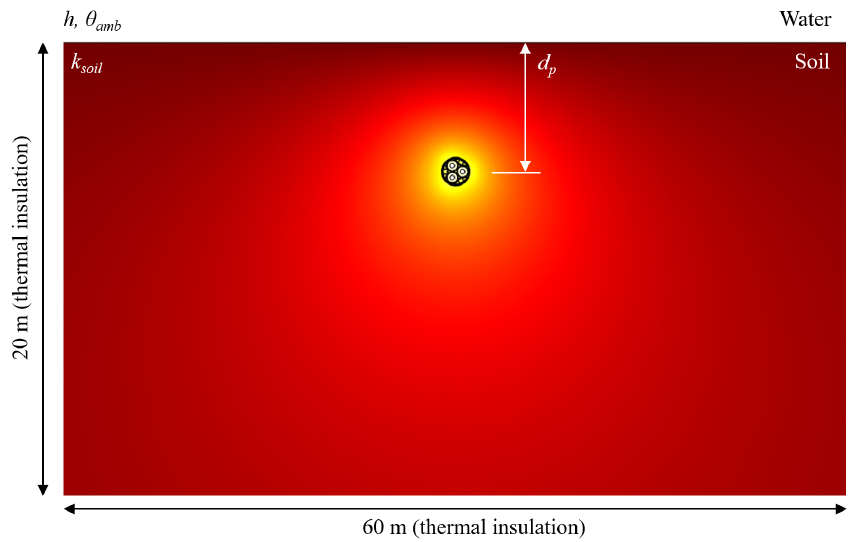
Figure 4. Temperature distribution in TCAC and